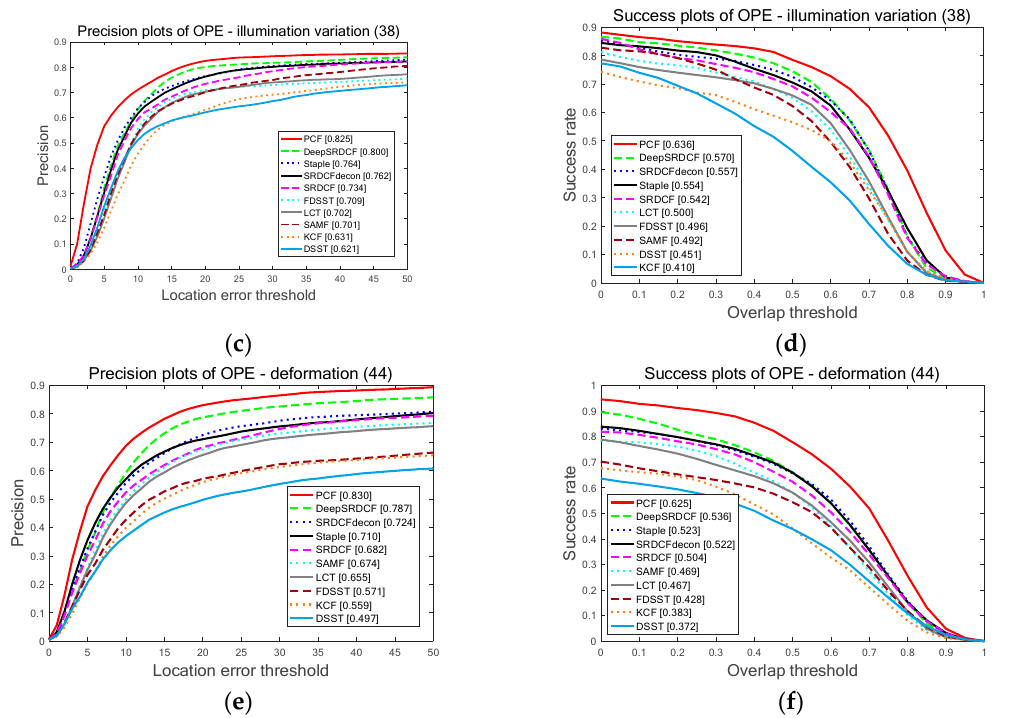
Figure 10. The quantitative results of the top ten trackers on OTB-2015 benchmark determined by three challenge contributions: DEF, OPR, and IV. Among the top ten trackers, the proposed PCF tracker achieves the top ranks in all three attributes: ( a ) The PP of the OPE on attribute DEF; ( b ) The SP of the OPE on attribute DEF; ( c ) The PP of the OPE on attribute OPR; ( d ) The SP of the OPE on attribute OPR; ( e ) The PP of the OPE on attribute IV; ( f ) The SP of the OPE on attribute IV.